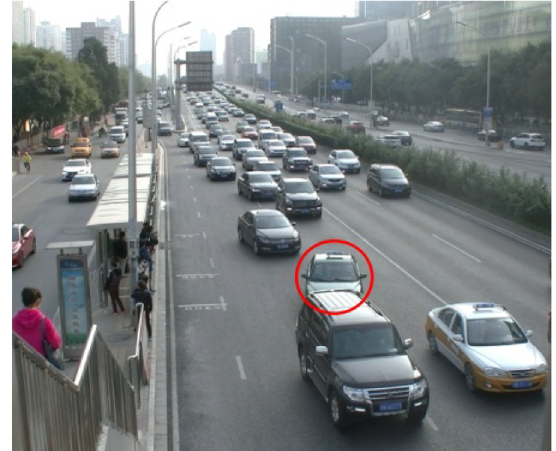
Figure 7 Non-standard lane change vehicles in the weaving